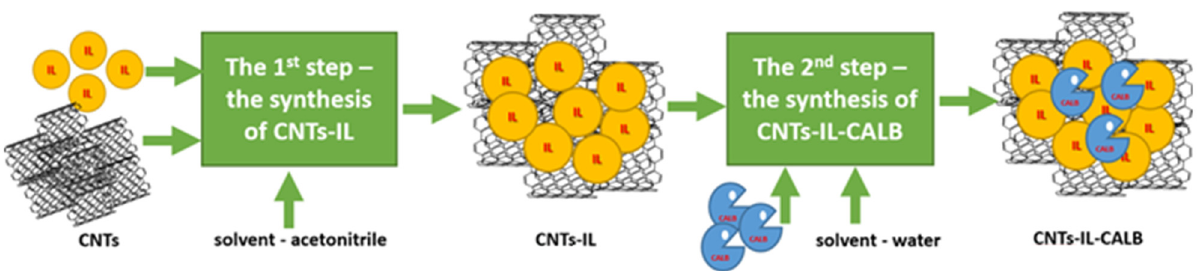
Scheme 3. The preparation of the CNTs-IL-CALB biocatalyst. Table 1. The influence of the preparation conditions of CNTs-IL-CALB on the biocatalyst